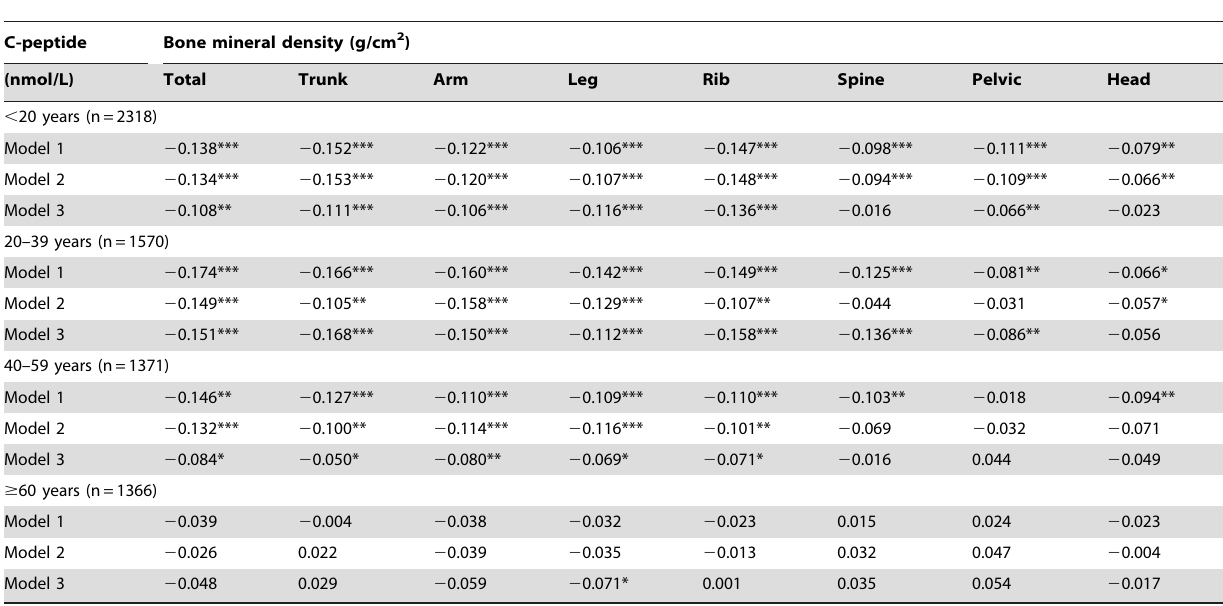
Table 3. The standardized regression coefficients of serum C-peptide level for total body and regional bone mineral density from multiple regression analysis stratified by age group.